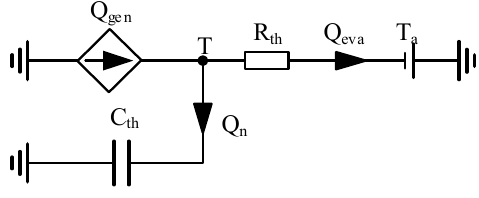
Figure 12. Supercapacitor thermal